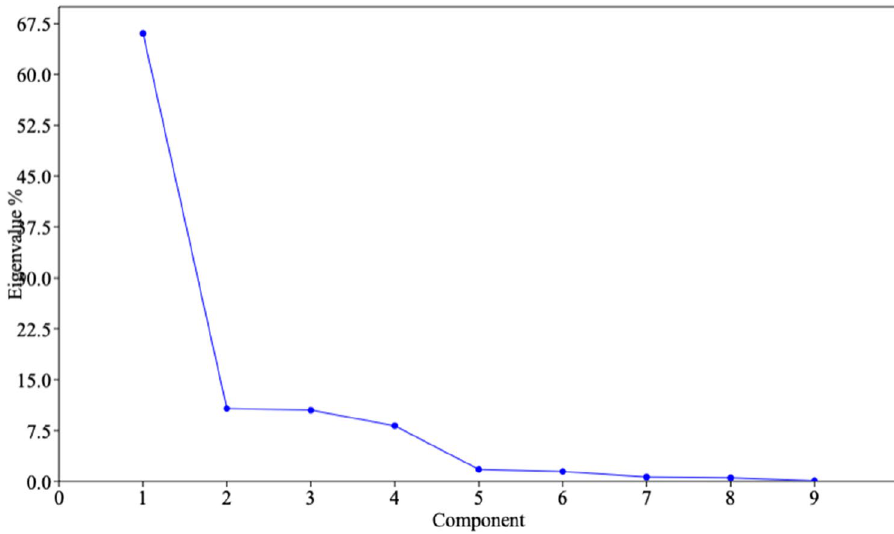
Figure 2. Scree plot of principal components against Eigenvalue.